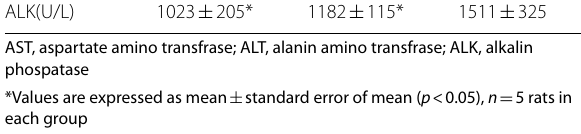
AST, aspartate amino transfrase; ALT, alanin amino transfrase; ALK, alkalin